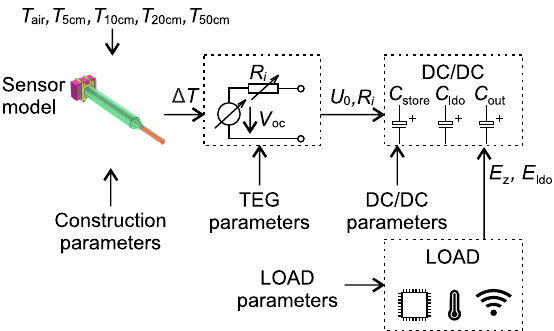
Figure 2. Block diagram of the simulation model. The sensor module supplies a DC/DC converter through the TEG module. The load simulates data transmission, control algorithm and data